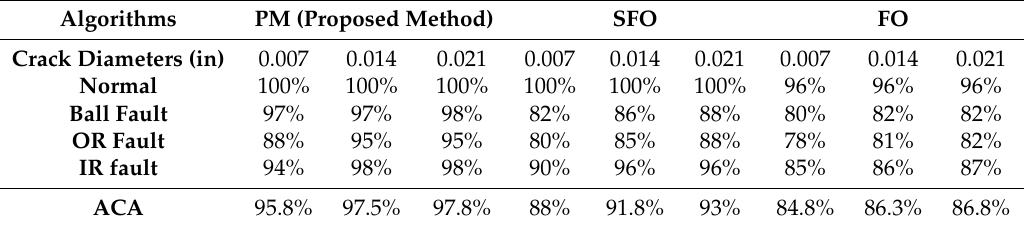
Table 7. The single fault diagnosis accuracy in the presence of load